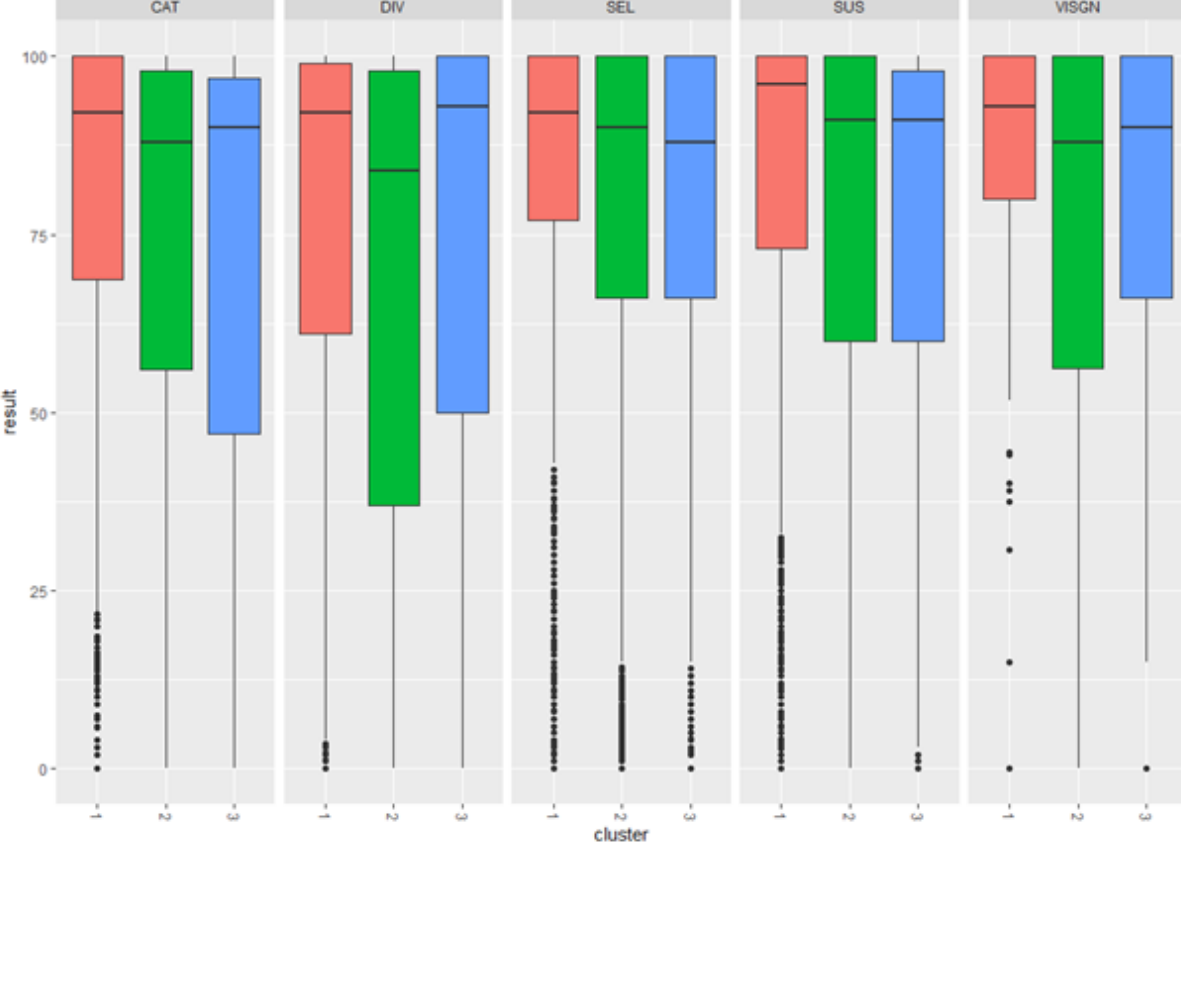
Figure 2. Tasks results boxplots for 5 cognitive functions: cluster 1 (red), cluster 2 (green), and cluster 3 (blue). CAT: categorization; DIV: divided attention; SEL: selective attention; SUS: sustained attention; VISGN: visual